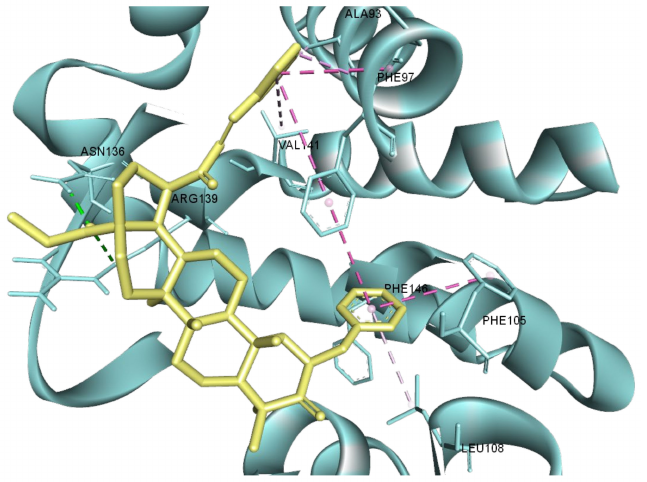
Figure 13. Structure of Bcl-XL (2YXJ) in complex with compound 7 (yellow); HB interactions are depicted as green dotted lines and hydrophobic interactions as purple dotted lines; interacting amino acids are shown as light blue